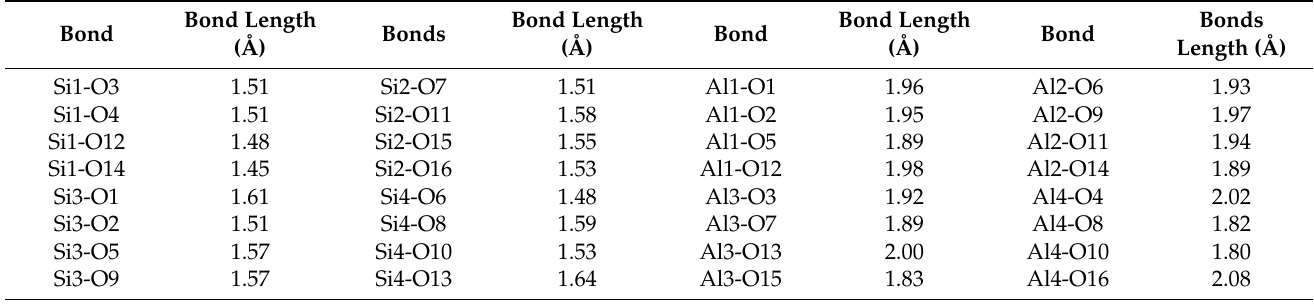
Table 5. The bond lengths of Si-O and Al-O in